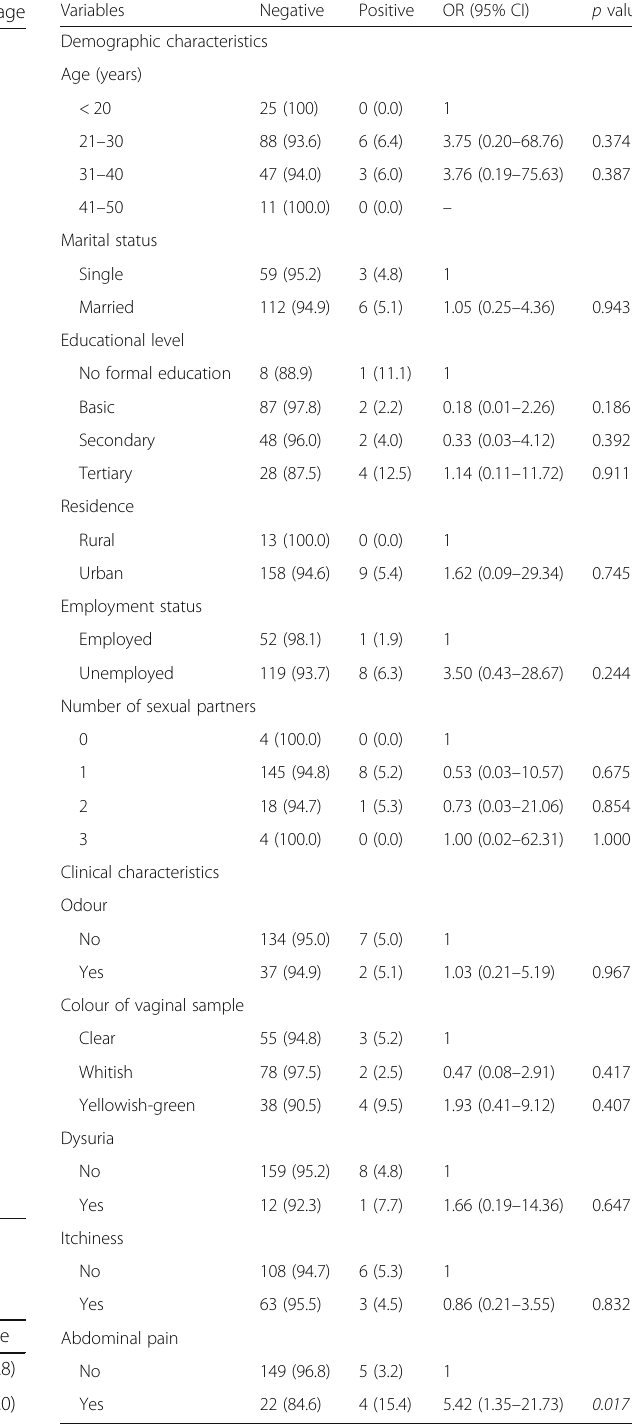
Table 3 Association between demographic and clinical characteristics and T. vaginalis